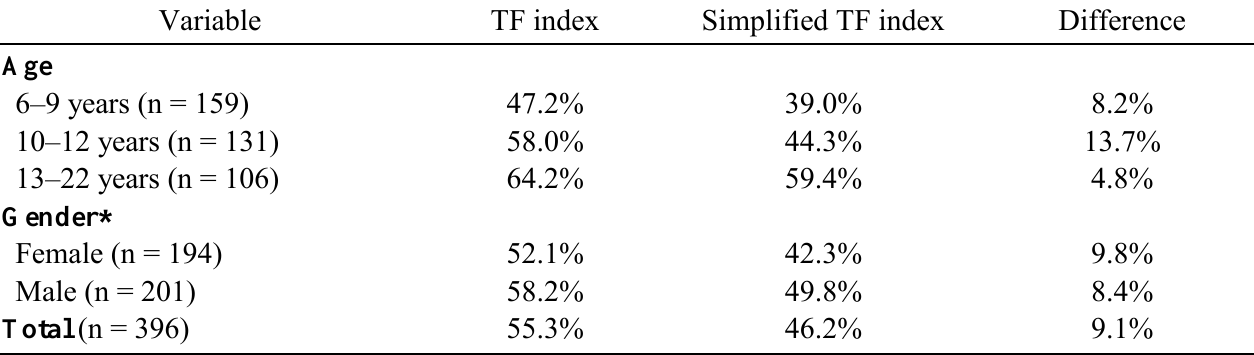
Table 3. Prevalence of severe fluorosis (TF index ≥ 3) according to age and gender using the full mouth TF index and simplified TF index, rural communities,